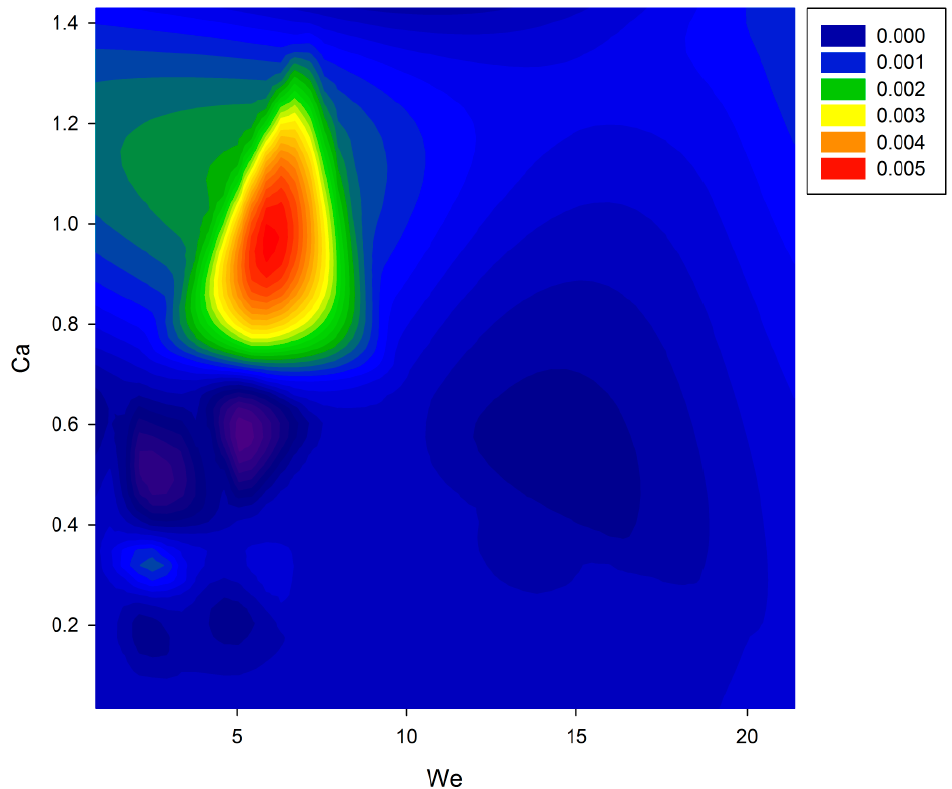
Figure 12. Break-up length as a function of the We–Ca space (obtained from the 25 runs).